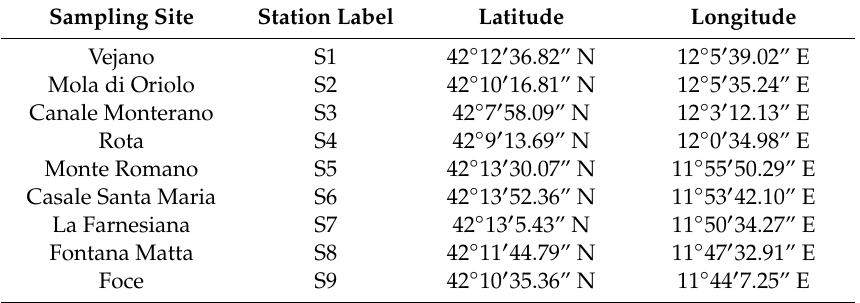
Table 2. Global Positioning System (GPS) coordinates of the stations on River Mignone sampled for water, sediments and macroinvertebrates during July